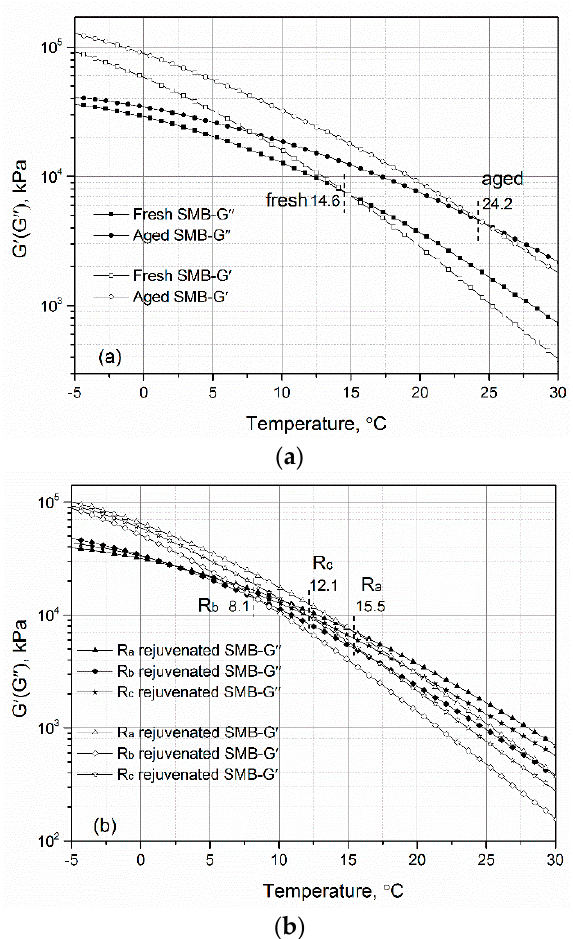
Figure 5. Viscous-elastic characteristics of ( a ) fresh and aged SMB and ( b ) rejuvenated SMB.